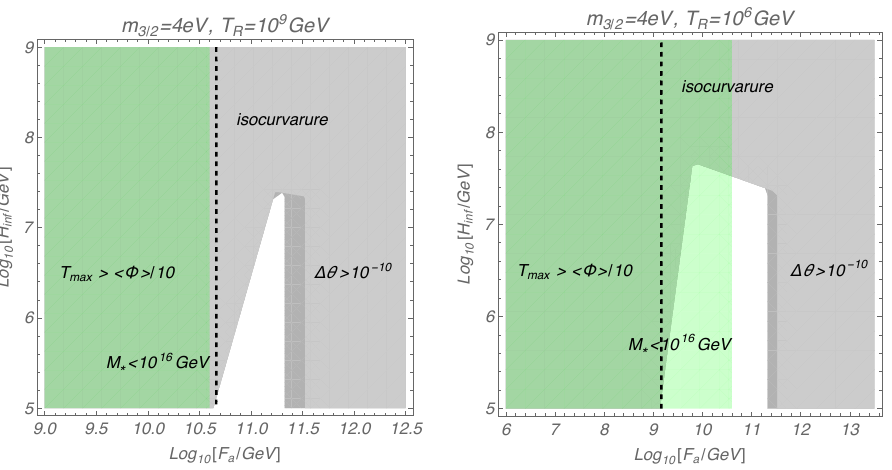
Figure 2 . (Left) Constraints on F a (cid:0) H inf for m = 4 eV and T R = 10 9 GeV. (Right) Con- 3 = 2 straints on F a (cid:0) H inf for m = 4 eV and T R = 10 6 GeV. The darker (lighter) gray shaded region 3 = 2 corresponds to the constraint of (cid:20) = 1 (10 (cid:0) 1 ) in eq. (4.1). In the green shaded regions, the gauge coupling constants become non-perturbative at a scale below 10 16 GeV. On the black dashed line, the current dark matter abundance is explained by the non-thermally produced saxion and axino. (For smaller F a , the abundance is larger.) See more details in the main